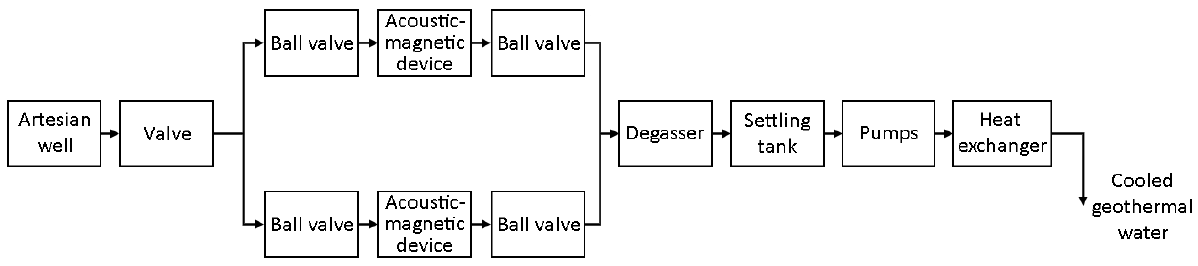
Figure 3. Functional diagram of the primary circuit of the heat exchanger of a heat supply system, including acoustic– magnetic devices.